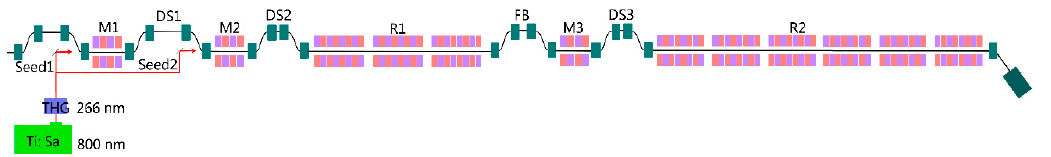
Figure 5. Layout of the undulator line.